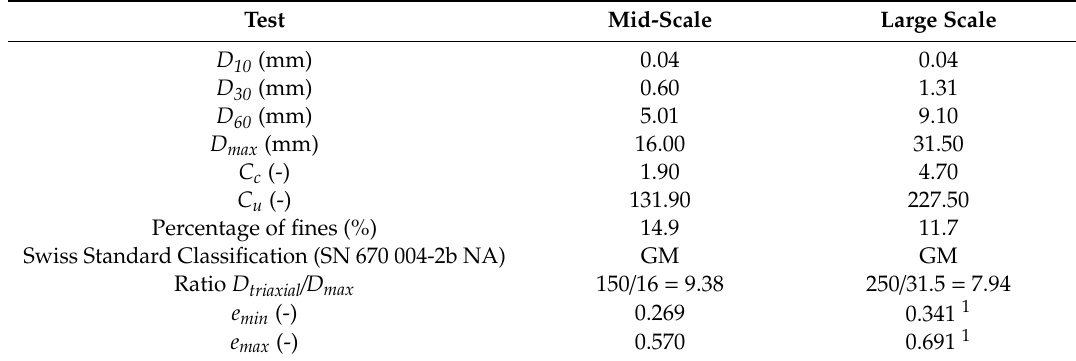
Table 1. Soil characteristics for the reconstituted triaxial specimens.